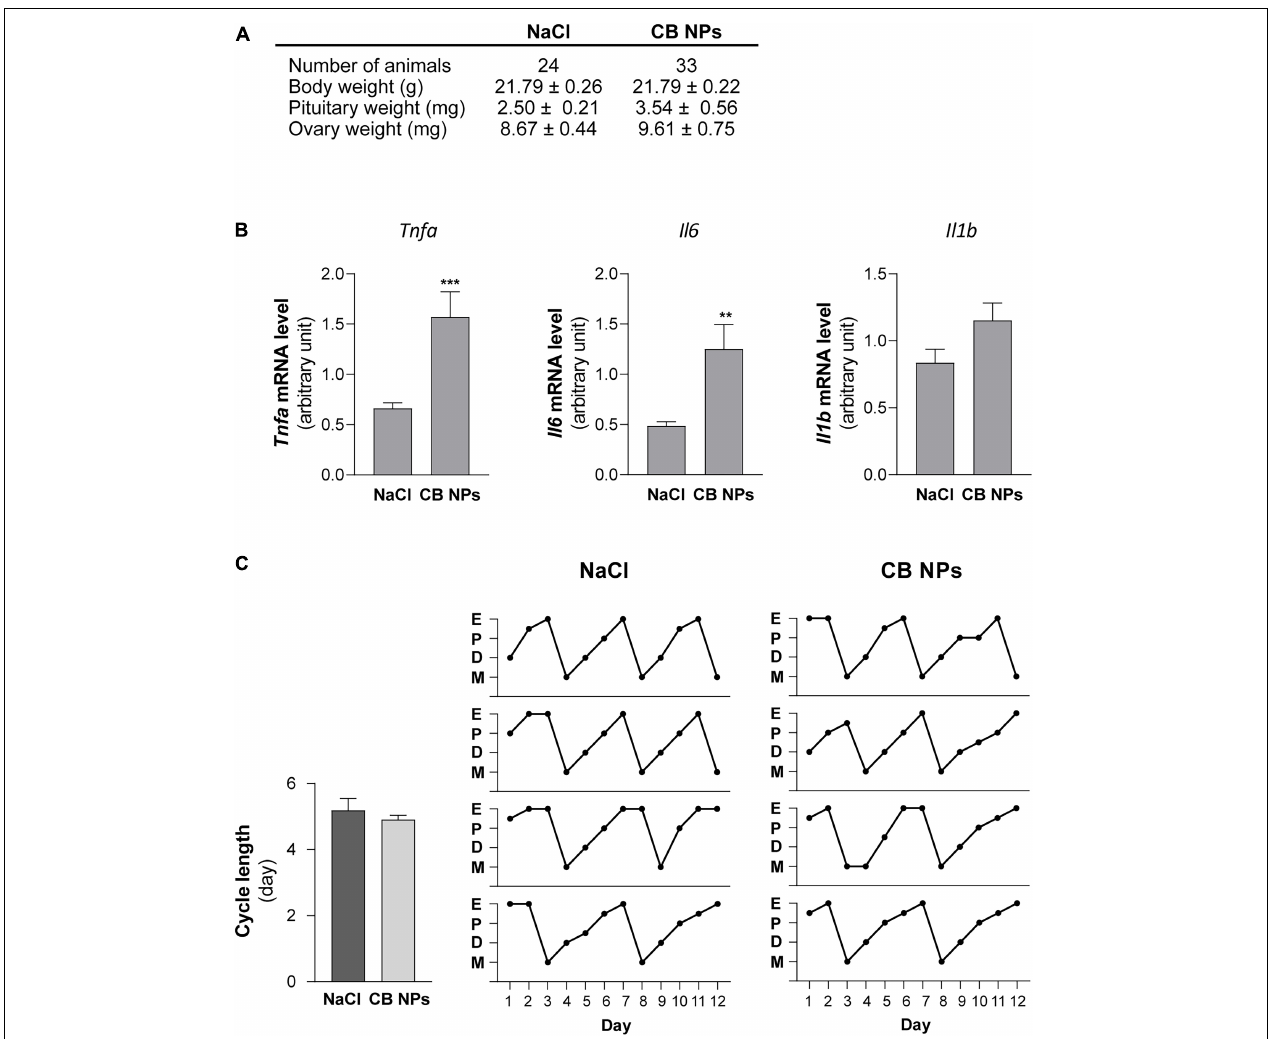
FIGURE 1 | Impact of CB NPs exposure on mice body and organs weights, pulmonary pro-inflammatory cytokine transcripts and estrous cyclicity. (A) Effect of CB NPs on body weights and relative organ weights of female mice after an intratracheal instillation with 100 µ g CB NPs/week during 4 weeks. (B) Transcript levels of canonical pro-inflammatory cytokines in lungs of female mice exposed to CB NPs. Control saline solution (NaCl, 0.9%) or CB NPs (100 µ g) were intratracheally administered to C57BL/6 mice once a week during four weeks as described in the Materials and Methods. Mice were sacrificed and lungs were collected. Tnfa , Il6 and Il1b mRNA levels were determined by real-time quantitative PCR in NaCl- and CB NP-treated mice (11 animals in each group). (C) Effect of CB NPs on mice estrous cyclicity. Left, Estrous cycle lengths were determined following CB NP exposure during the 12 days preceding sacrifice. No difference in cycle lengths was observed between mice exposed to NaCl or CB NPs (5.19 ± 0.35 in control mice ( n = 24) versus 4.91 ± 0.13 days in CB NP-treated mice ( n = 33). Right, Diagrams representing the estrous cycles at each stage (E: estrous; P: proestrous; D: diestrous; M: metestrous) for four representative controls and CB NPs mice monitored daily during the 12 days preceding sacrifice. At the time of sacrifice, percentages of mice in each stage of the estrous cycle were roughly similar between the two groups of mice: 16.7, 25, 29.1, and 29.2% in proestrous, estrous, diestrous and metestrous, respectively in controls vs. 18.2, 30.3, 24.2, and 27.3% in proestrous, estrous, diestrous and metestrous, respectively in CB NP-treated mice. Data are expressed as means ± SEM. Statistical differences were determined by the Mann-Whitney test. ** p < 0.01 and *** p < 0.001 compared to NaCl.